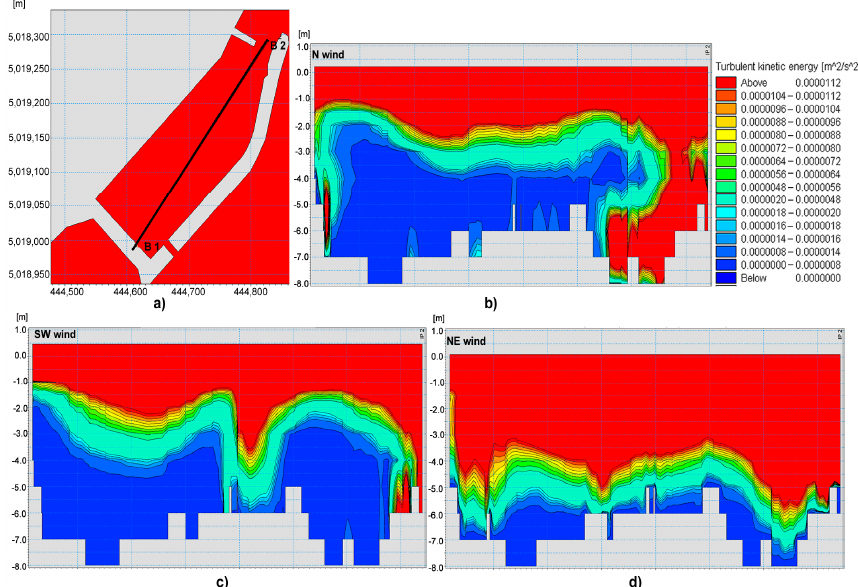
Figure 13. Turbulent kinetic energy field for the wind of 4.5 m/s speed trough vertical cross-section B1–B2: ( a ) the cross-section B1–B2 position; ( b ) TKE on 10th of March, 19:00 h for N wind; ( c ) TKE on 4th of March 22:00 h for SW wind; ( d ) TKE on 14th of July 10:00 h for NE wind.